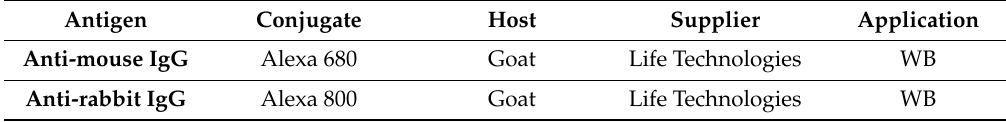
Table 3. Details of secondary antibodies used for